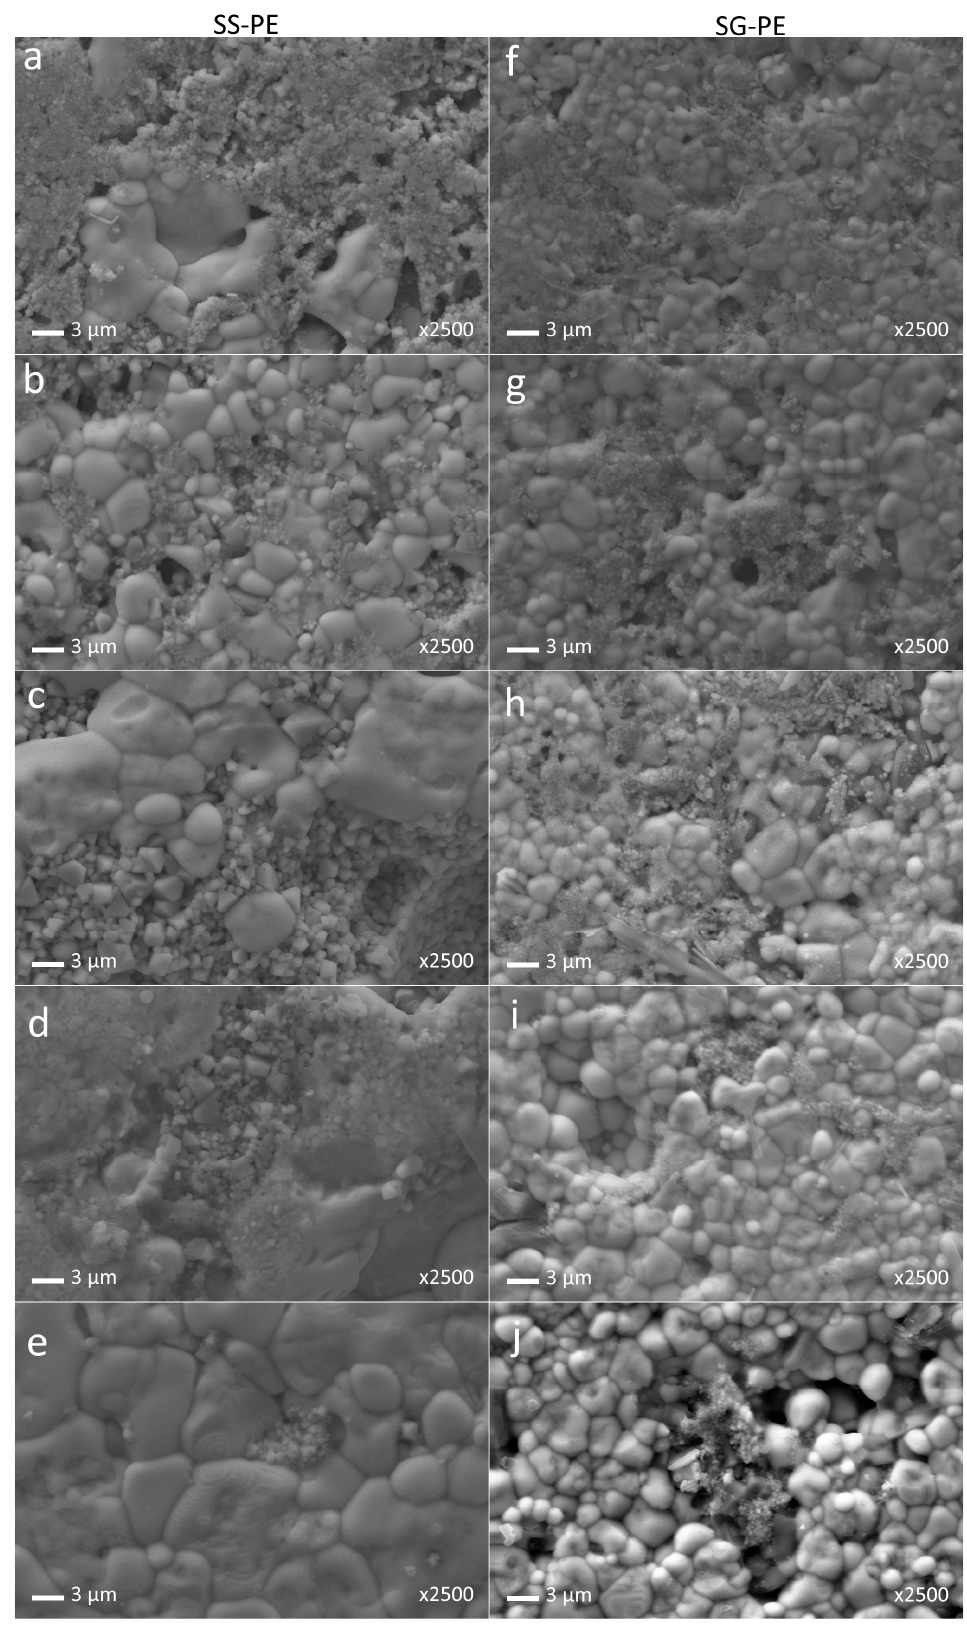
Figure 3. SEM images of the xBNKT-(100-x)NCF (x = 60 ( a , f ), 70 ( b , g ), 80 ( c , h ), 90 ( d , i ), 95 ( e , j )) sintered composites.